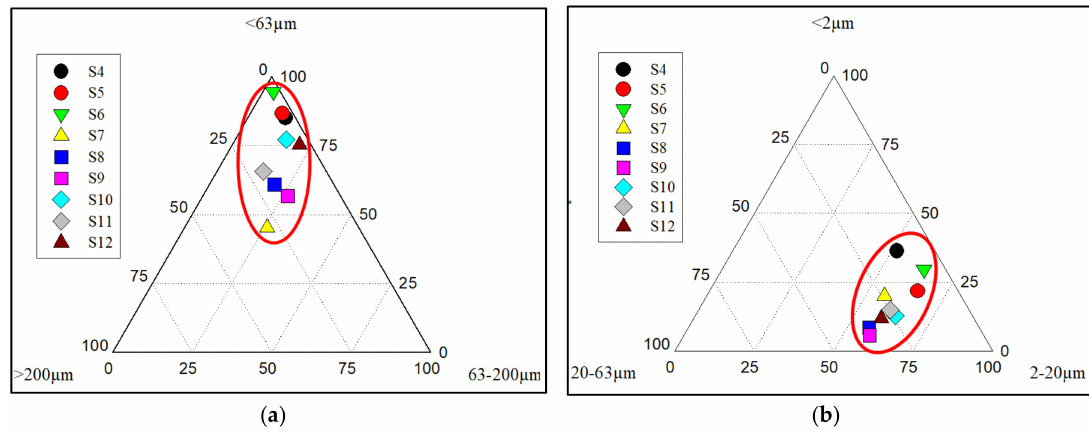
Figure 2. Ternary textural diagrams of bottom sediments of the Lom é lagoon: ( a ) for the total fractions ( < 2 mm), ( b ) for the fine fractions ( < 63 µ m). S4 to S12 are the di ff erent sampling stations (see locations in Figure 1).